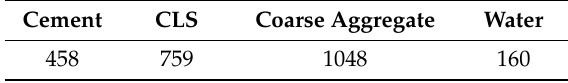
Table 3. Mixture of crushed limestone sand concrete (unit: kg/m 3